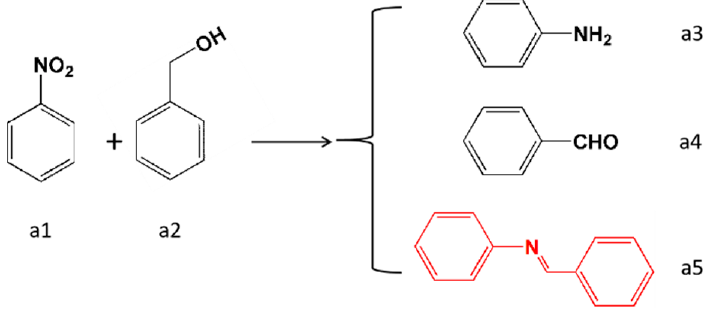
Figure 4. Photocatalytic One-Pot Synthesis of Imine from Nitrobenzene and Benzyl alcohol.